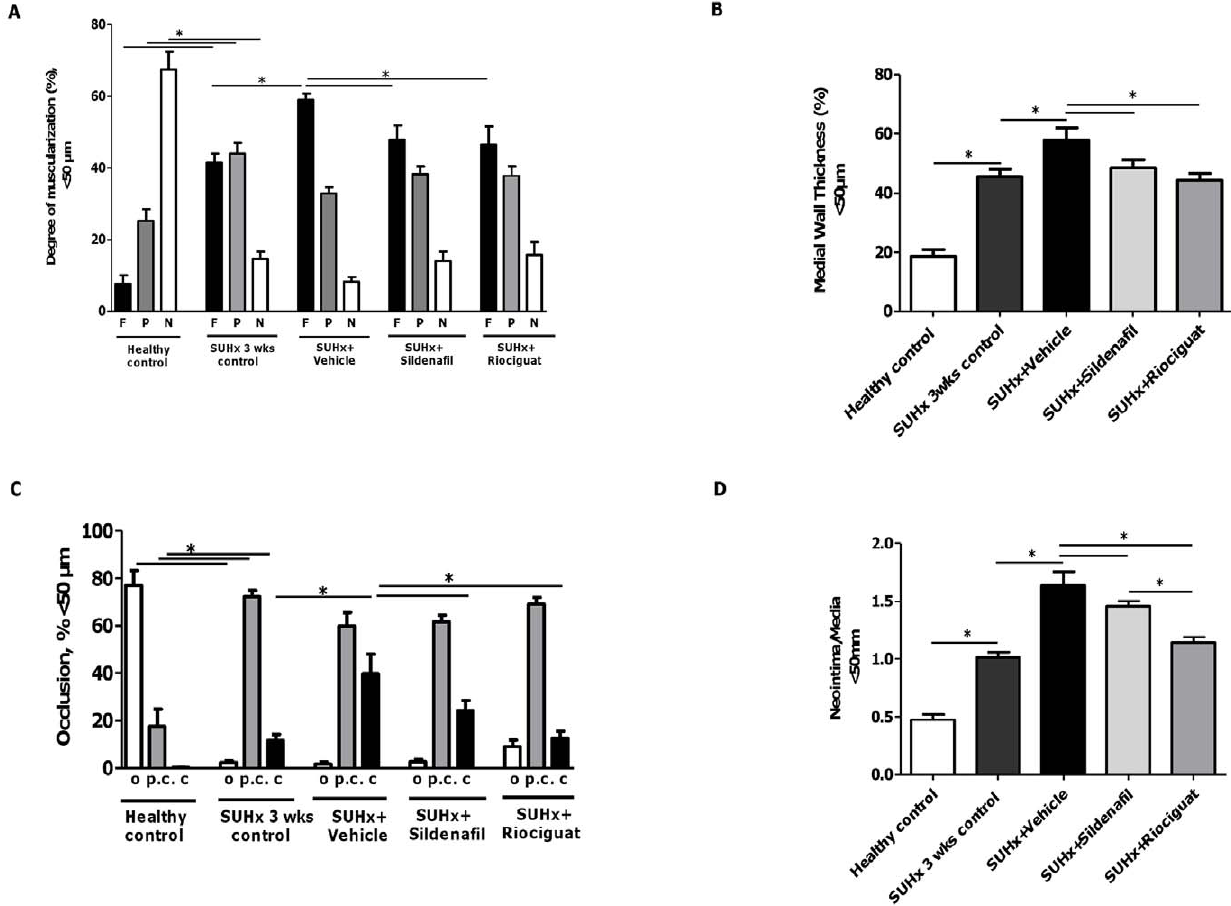
Figure 3. Effects of riociguat and sildenafil on pulmonary vascular remodeling in SUHx rats. (A) Proportion of non-, partially or fully muscularized pulmonary arteries as a percentage of the total pulmonary artery cross section ( , 50 m m); (B) proportion of medial wall thickness of the small pulmonary arteries ( , 50 m m); (C) proportion of opened, partly closed and closed small pulmonary arteries ( , 50 m m) and (D) neointima/media ratio of the small pulmonary arteries ( , 50 m m) of different treatment groups. * p , 0.05. Note. c, closed; F, fully muscularized; N, non-muscularized; o, opened; P, partially muscularized; pc, partly closed.